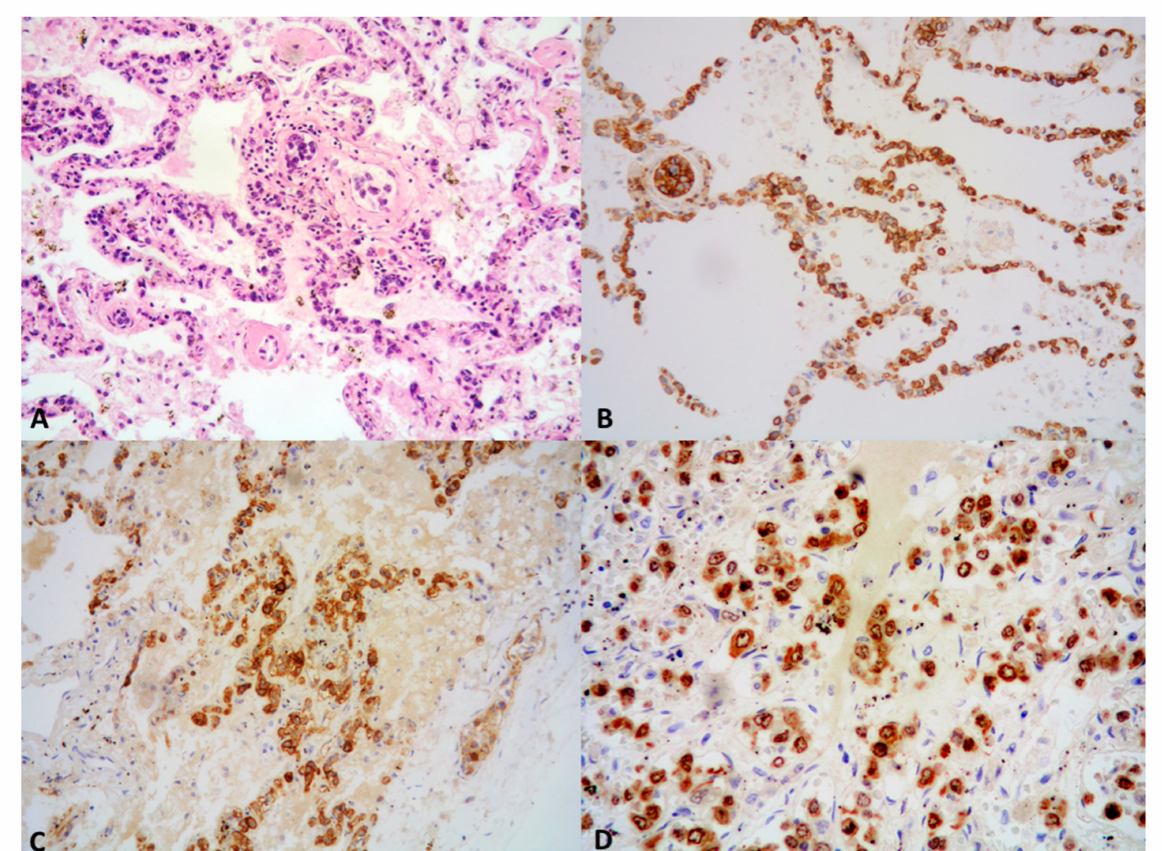
Figure 6. Intravascular large B-cell lymphoma. ( A ). Large neoplastic cells fill the vessels within the interstitial spaces (H&E stain, 200 × ). ( B – D ). Tumor cells are positive for CD45 ( B ), CD20 ( C ), and show a high proliferative index, i.e., >90% tumor cells showing nuclear immunoreactivity ( D ) (( B ) CD45 immunostain, 200 × ; ( C ) CD20 immunostain, 200 × ; ( D ) Ki-67 immunostain, 400 ×